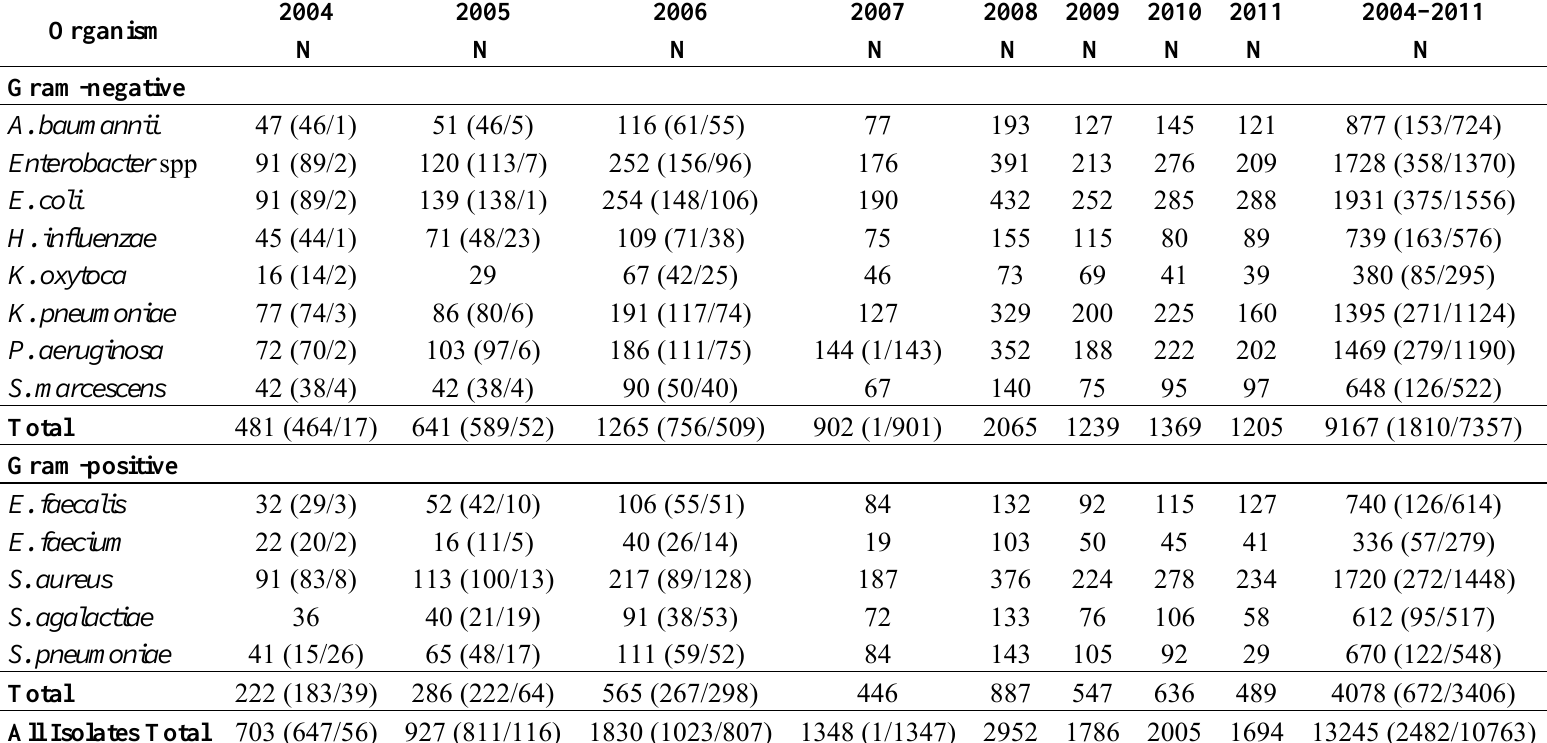
Table 1. Numbers of Gram-negative and Gram-positive isolates collected in Italy during Tigecycline Evaluation and Surveillance Trial (T.E.S.T.)